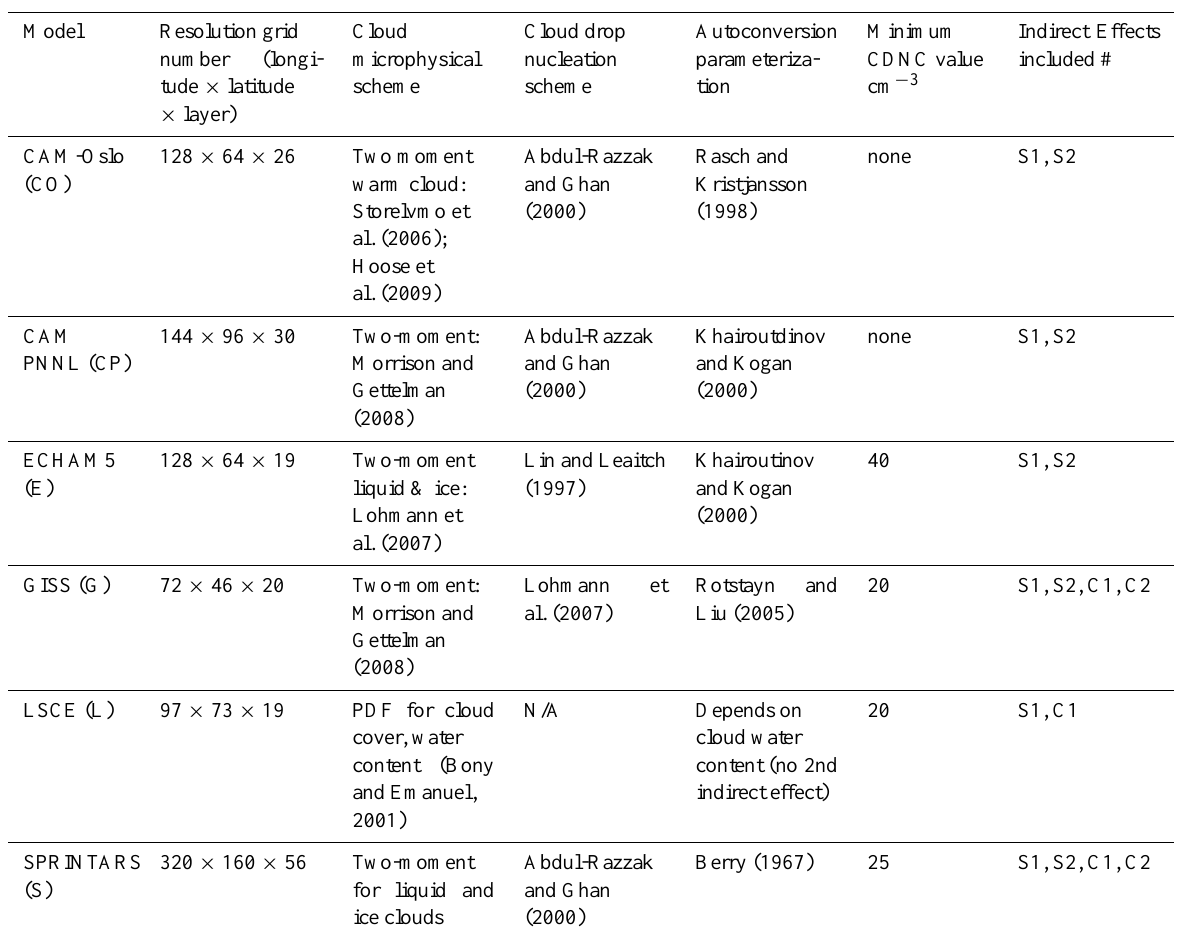
Table 2. Model and cloud microphysical information.